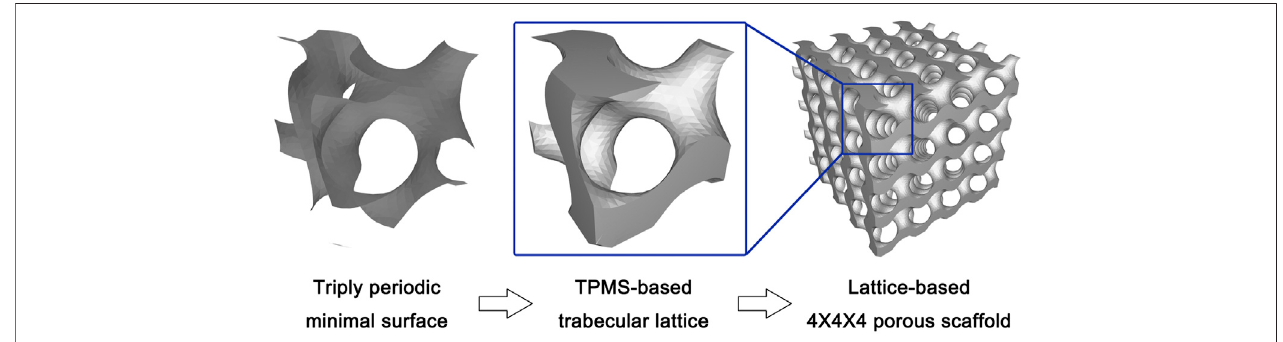
FIGURE 1 | The schematic diagram of design process from triply-periodic minimal surface (TPMS) to TPMS-based porous